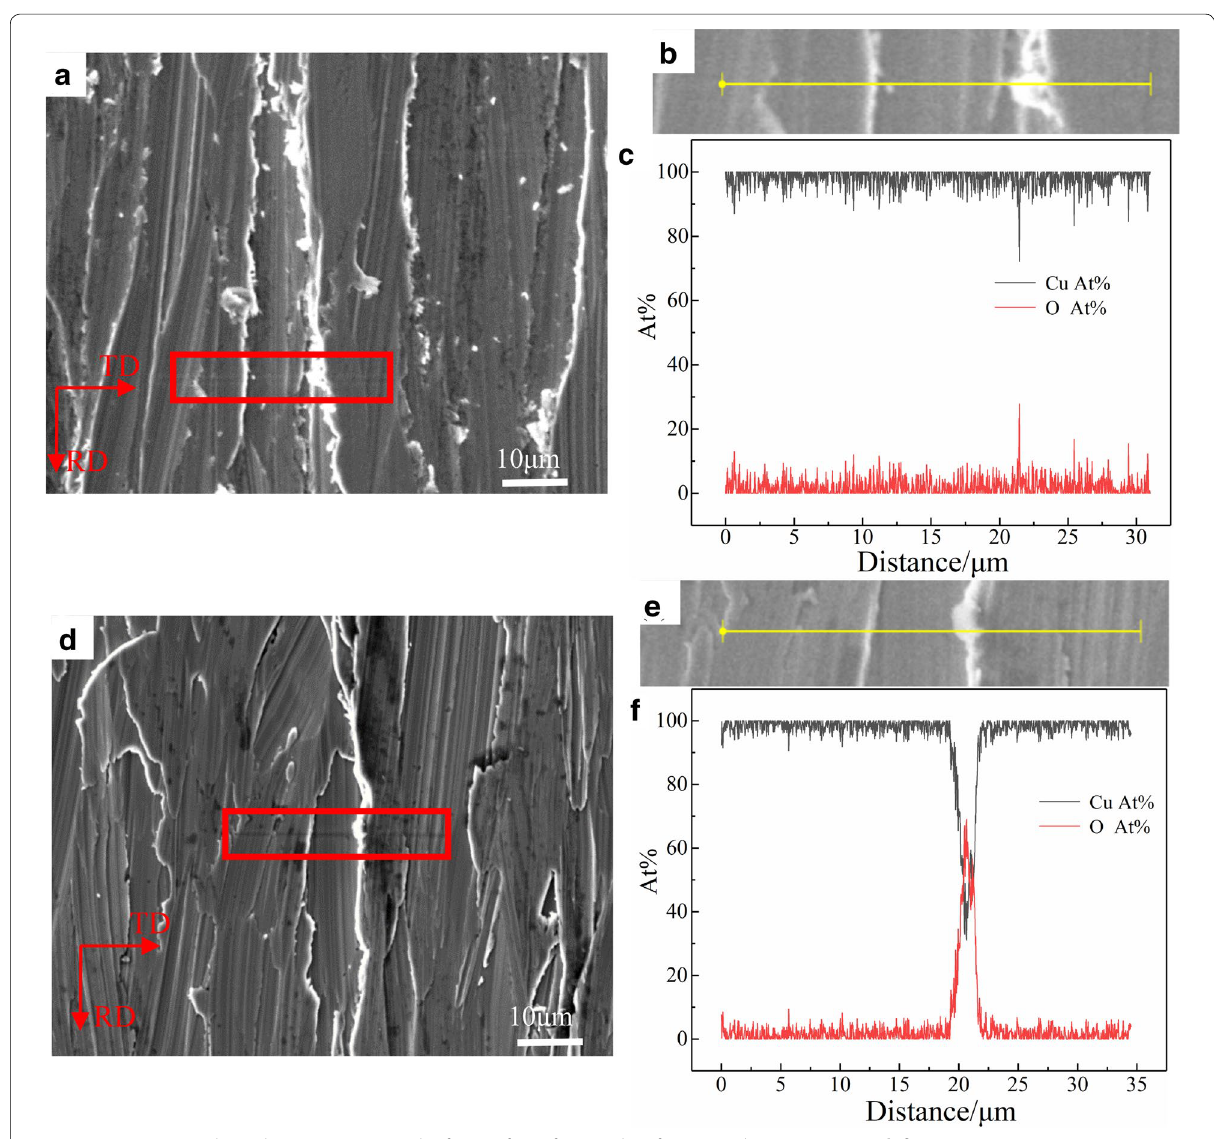
Fig. 10 SEM micrographs and EDS scanning result of Cu surface after grinding for 10 s and 30 s: ( a – c ) 10 s; ( d – f ) 30 s